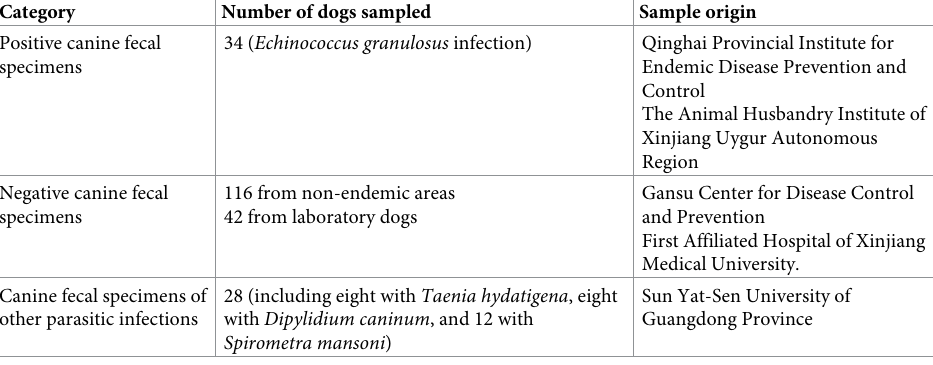
Table 3. Composition and origin of